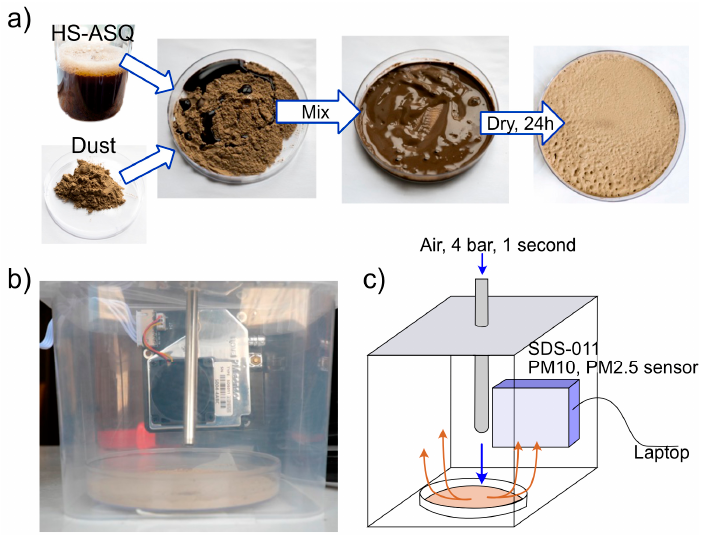
Figure 3. Preparation of beds with samples ( a ) and a photo ( b ) and the scheme ( c ) of the wind erosion resistance test installation.